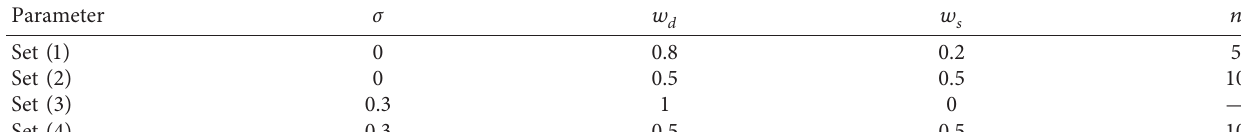
Table 1: Parameter values employed to generate the shading images.